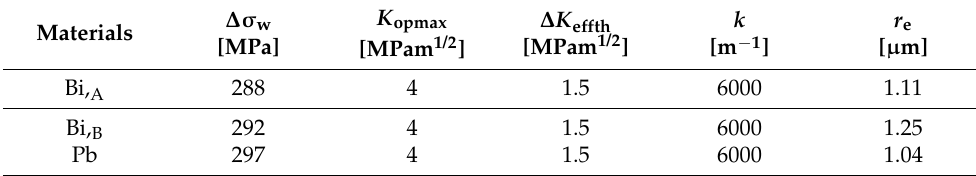
Table 3. Parameter values used to calculate M